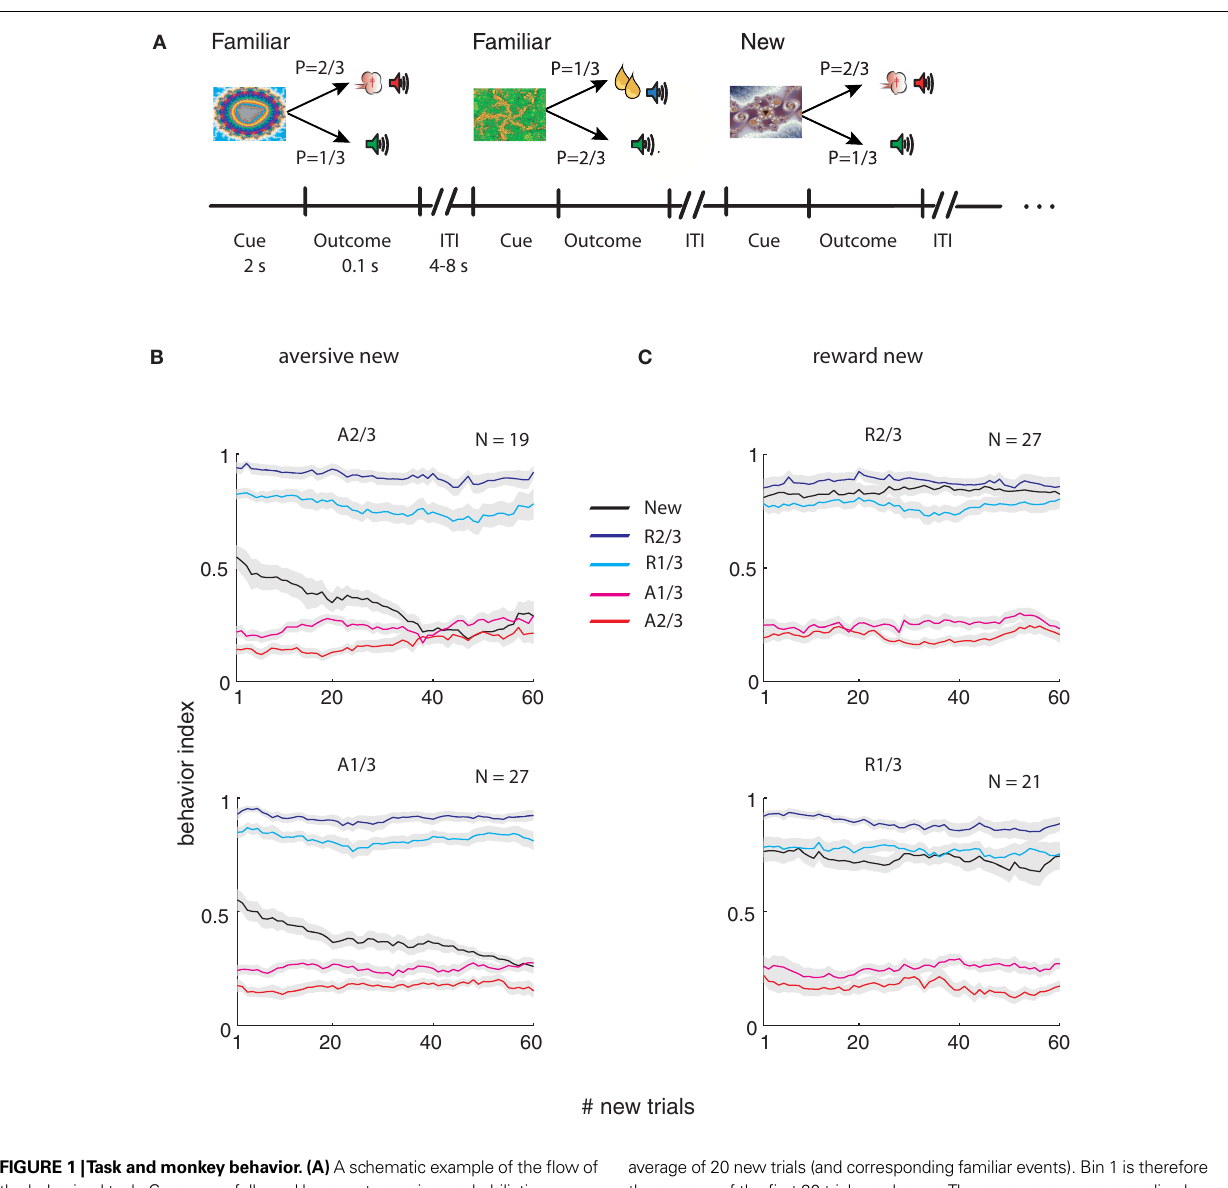
FIGURE 1 | Task and monkey behavior. (A) A schematic example of the fl ow of the behavioral task. Cues were followed by an outcome in a probabilistic manner. In each recording session a new cue was randomly interleaved between familiar cues. In this example the right fractal image is a new cue that follows familiar cues (the two left cues). (B) Behavior index (average ± SEM, across behavioral sessions) as a function of the number of new aversive trials. In each session the behavioral response (Lick – Blink) was calculated in a moving